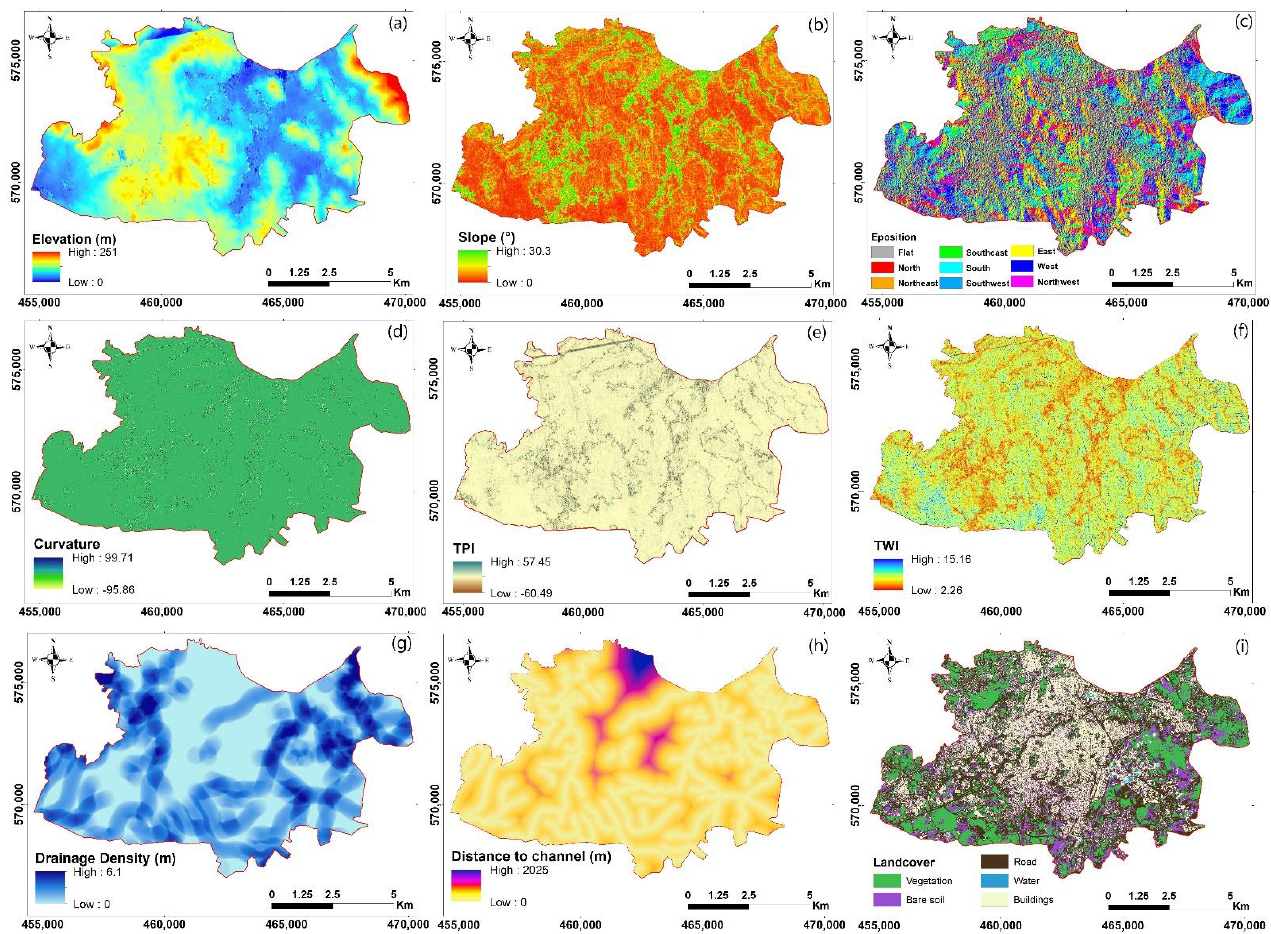
Figure 3. Map of the geo-environmental factors of the study area: ( a ) elevation; ( b ) slope; ( c ) exposition; ( d ) curvature; ( e ) TPI; ( f ) TWI; ( g ) drainage density; ( h ) distance from channel; ( i ) land cover.